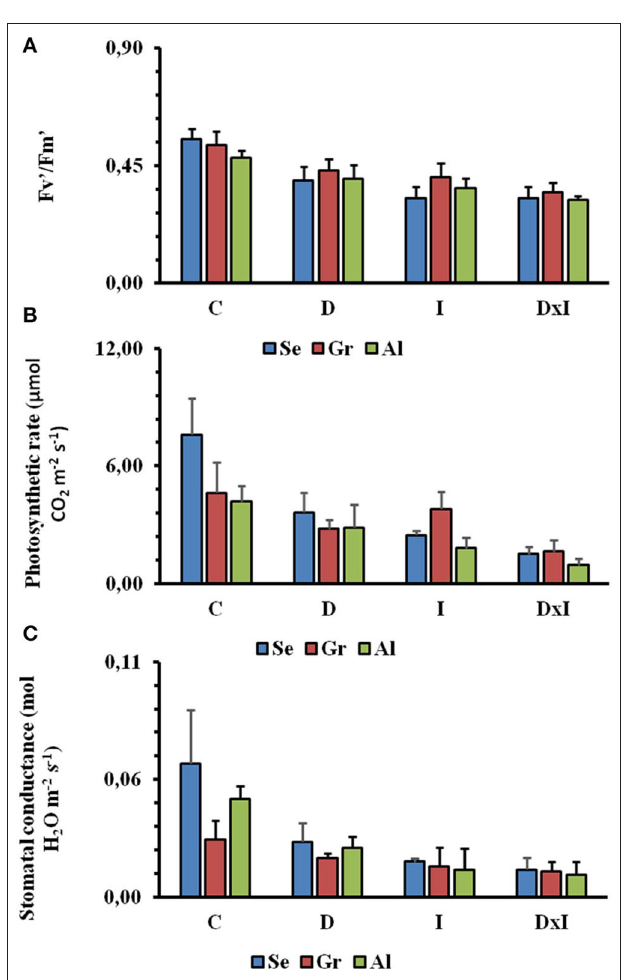
FIGURE 4 | Mean values of F ′ v /F ′ m (A) , net photosynthesis rate (B) , and stomatal conductance (C) in the Seville (Se), Granada (Gr), and Almeria (Al) populations from day 8 to day 32. Treatments: control (C), drought (D), inoculation (I), and combined (D × I). Different letters denote significant differences among treatments ( p <